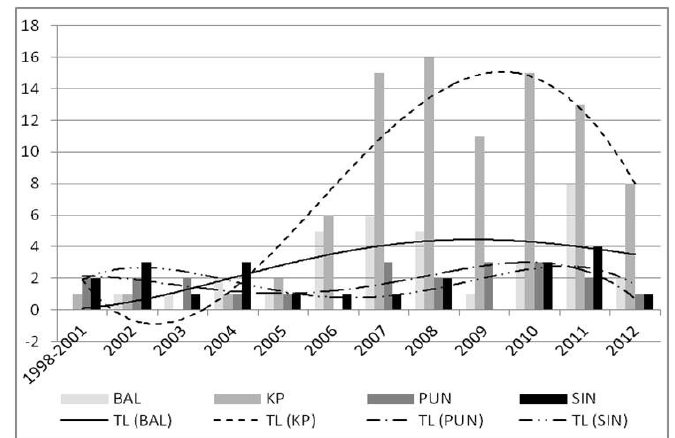
Figure 10. Number of Event–Method clusters obtained annually for each province.